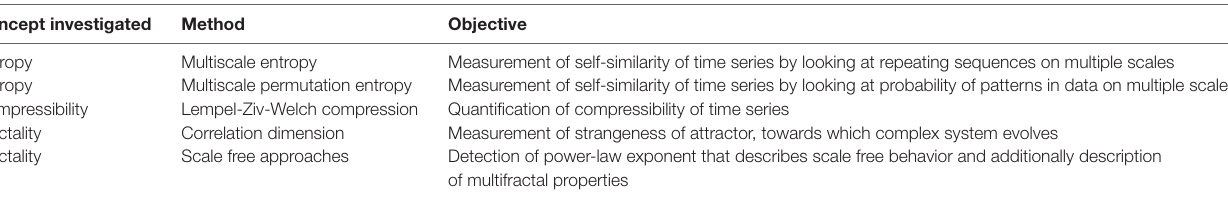
TABLE 1 | Overview used